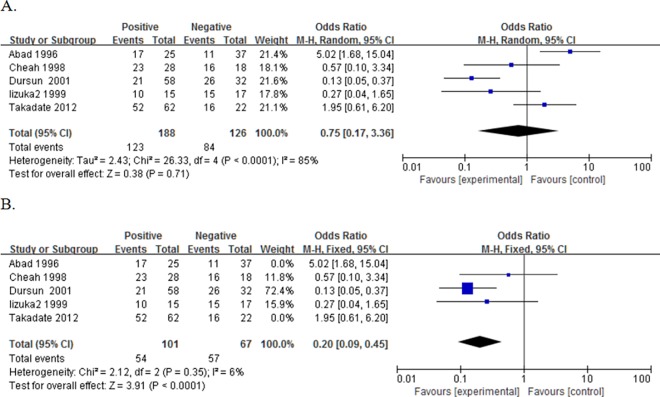
Forest plot of odds ratio (OR) for the association between NME1 overexpression and disease-free survival (DFS) in patients with digestive system cancers.A. The ORs for DFS; B. The new ORs for DFS.